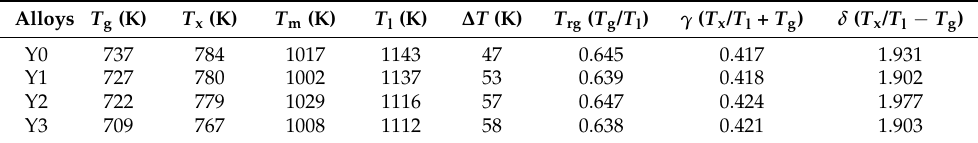
Table 1. The thermodynamic parameters of the Y0, Y1, Y2 and Y3 alloys. Alloys T g (K) T x (K) T m (K) T l (K) ∆ T (K) T rg ( T g / T l ) γ ( T x / T l + T g